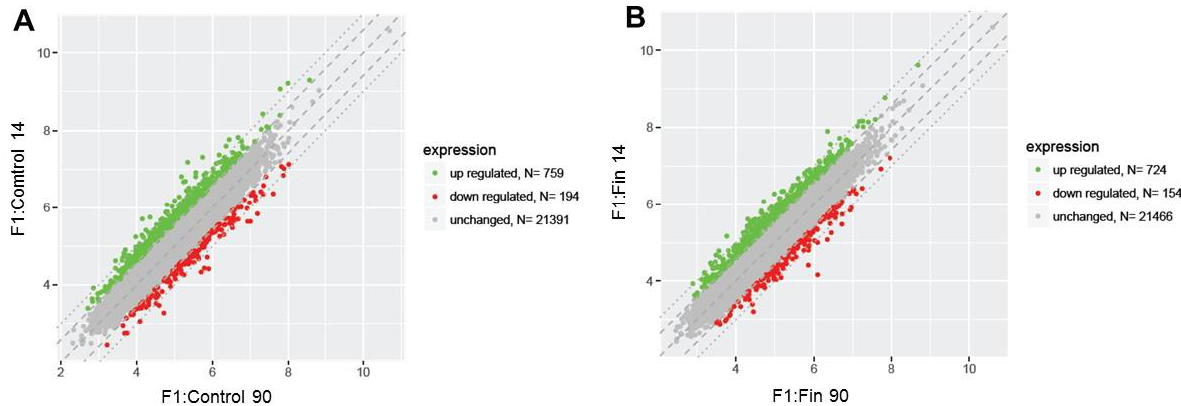
Figure 2. Scatter plots illustrating differentially expressed genes (DEGs) in the four experimental comparison groups: F1:Control 14 vs. F1:Control 90 ( A ), F1:Fin 14 vs. F1:Control 90 ( B ). Each dot represents a single gene. The selection criteria for significantly changed gene expression were based on a greater than 1.5-fold difference in expression.